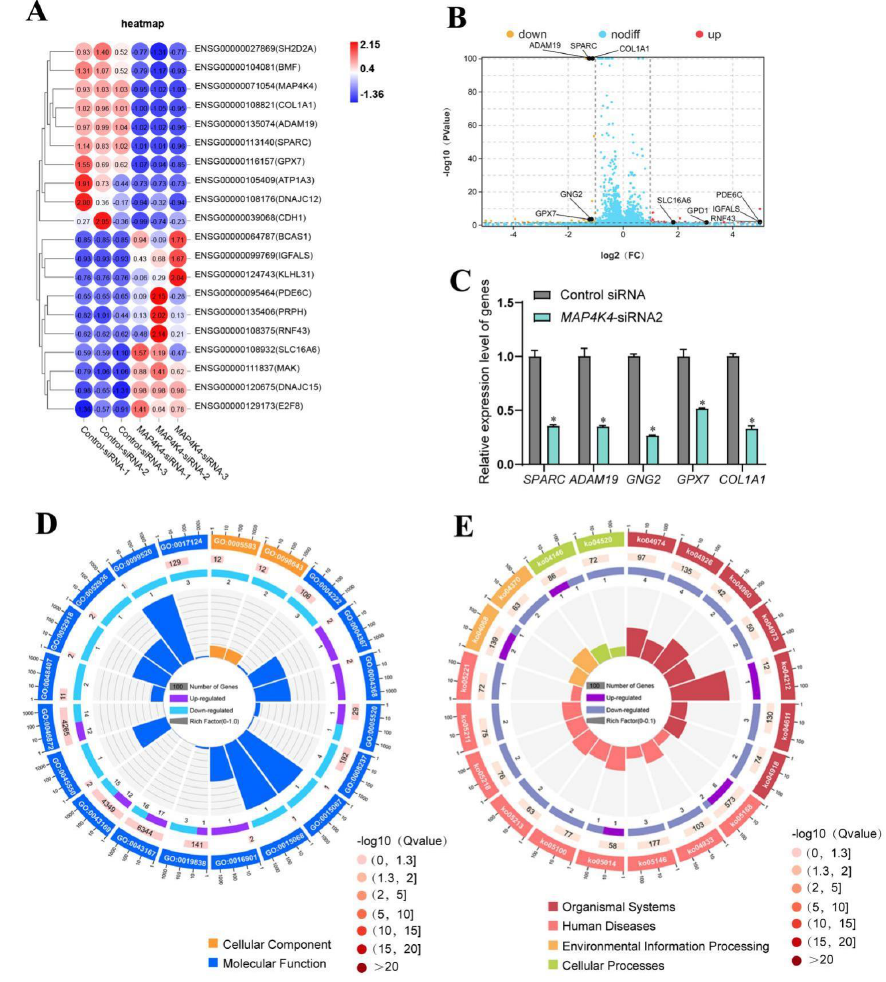
Figure 6. The identification of MAP4K4 target genes in human SSC line. ( A ) Hierarchical clustering demonstrates the top 20 DEGs in the human SSC line between control siRNA and MAP4K4-siRNA2. ( B ) Volcano plots show the differences between control siRNA and MAP4K4-siRNA2. ( C ) QPCR evaluated the mRNA in SPARC, ADAM19, GNG2, GPX7, and COLA1 in human SSC line by control siRNA and MAP4K4-siRNA2. ( D ) GO circle plot illustrated the top 20 enrichment terms. First circle: GO terms of the top 20 enrichments, and outside circle was the sitting scale of the number of genes. Different colors denoted the different ontologies; the second circle: the number of DEGs was en- riched in this GO term and the Q -value. The more genes, the longer the bar; the smaller the Q -value, the more red the color; the third circle: the bar chart of the proportion of DEGs, and purple denoted the fraction of up-regulated genes. Light blue denoted the proportion of down-regulated genes, and